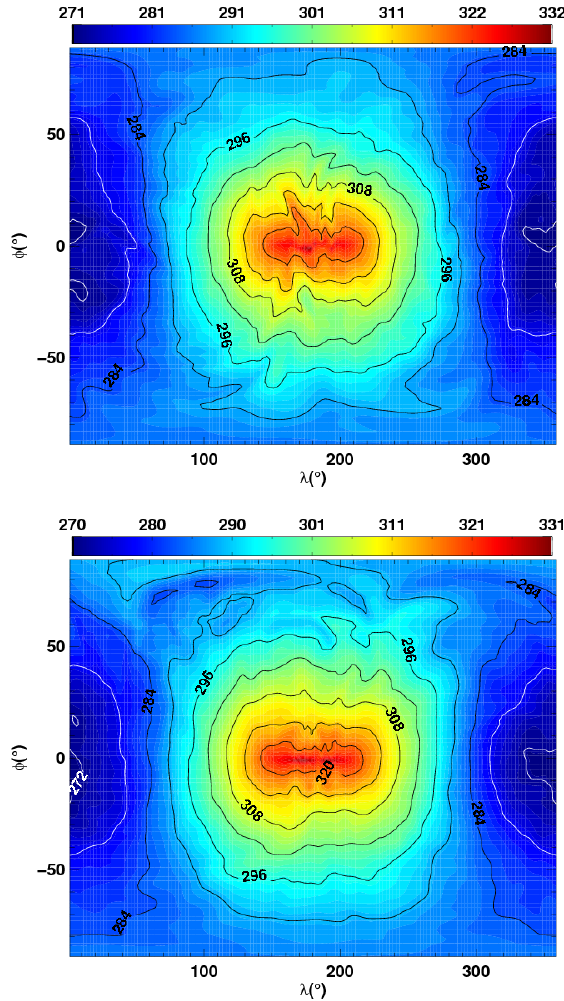
Figure 19. Figure showing, for the tidally locked Earth test (Merlis and Schneider, 2010; Heng et al., 2011b), showing temperature at Fig. 19. Figure showing, for the Tidally Locked Earth test (Merlis 1200 days and σ = 0 . 975, for the EG models (see Table 2 for ex- Fig. 19. Figure showing, for the Tidally Locked Earth test (Merlis planation of model types) using α of 0 . 55 and 1 . 0 (top and bottom and Schneider, 2010; Heng et al., 2011b), showing temperature at and Schneider, 2010; Heng et al., 2011b), showing temperature at panels, respectively). 1200 days and σ = 0 . 975 , for the EG models (see Table 2 for ex- 1200 days and σ = 0 . 975 , for the EG models (see Table 2 for ex- planation of model types) using α of 0 . 55 and 1 . 0 ( top and bottom planation of model types) using α of 0 . 55 and 1 . 0 ( top and bottom panels , respectively). panels , respectively).